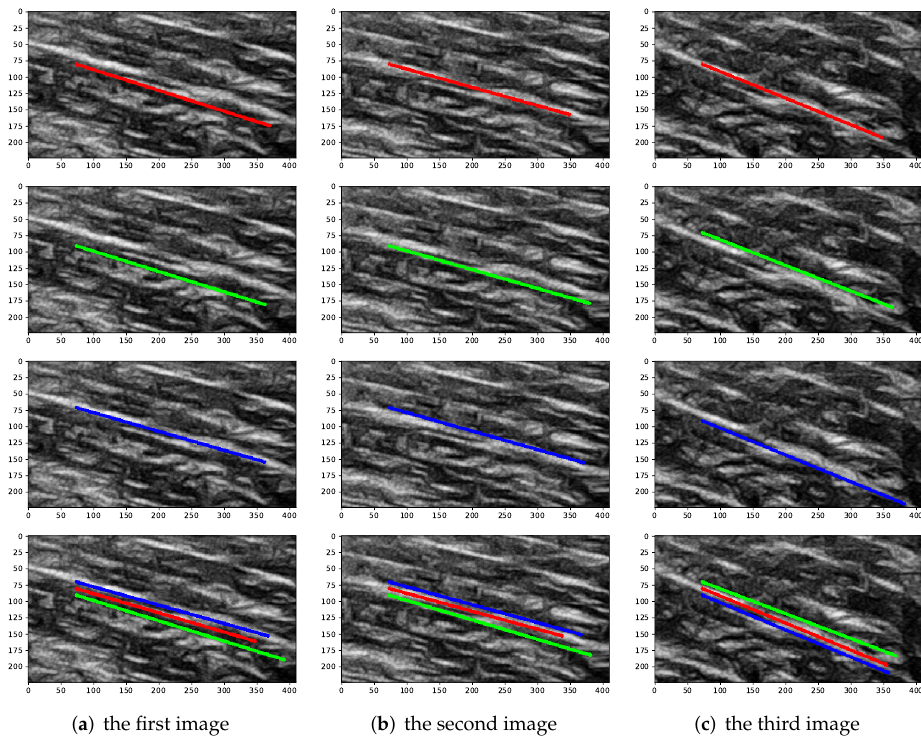
( a ) the first image ( b ) the second image ( c ) the third image Figure 5. The detection results of the method are on three different images. The red line is the result of manual annotation, the green line is the result before adding the improved Kalman filter, and the blue line is the result of the method proposed in this